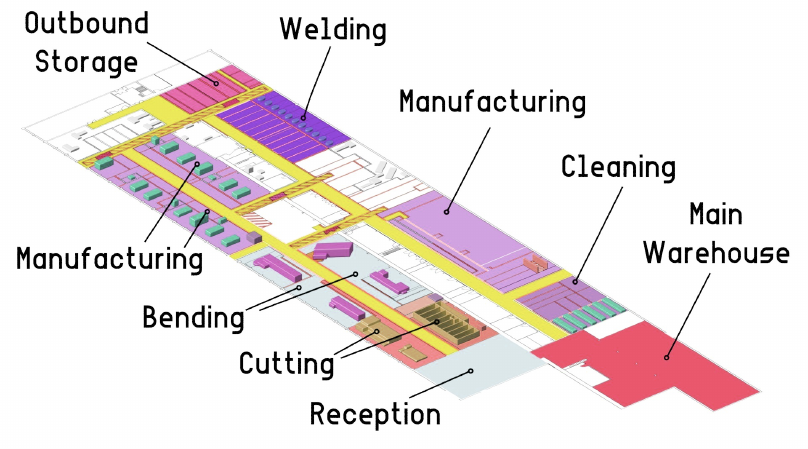
Figure 2. Navantia’s pipe workshop in Ferrol (Spain).